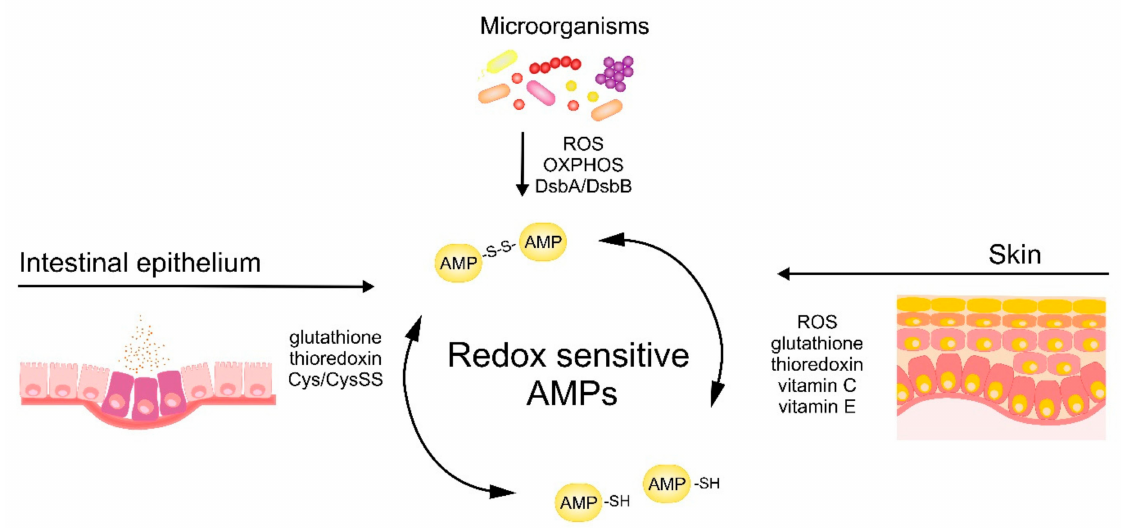
Figure 3. Skin-, intestinal epithelium- and microbe-driven mechanisms influencing redox status and bactericidal potential of